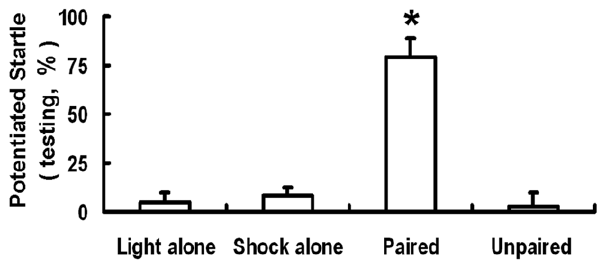
Figure 1. Fear-potentiated startle values in light alone, shock alone, paired CS-US and unpaired CS-US groups. Rats in the paired group received 7 light-shock pairings, whereas the unpaired rats received 7 lights and 7 shocks in a pseudorandom manner. Light alone (n=8); shock alone (n=8). * p , 0.05, paired (n=12) vs. unpaired (n=8).